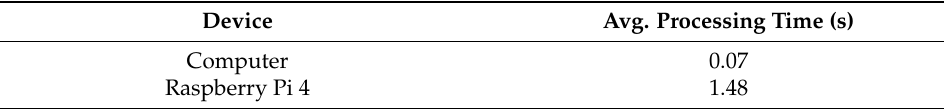
Table 7. Average image processing time on the two test